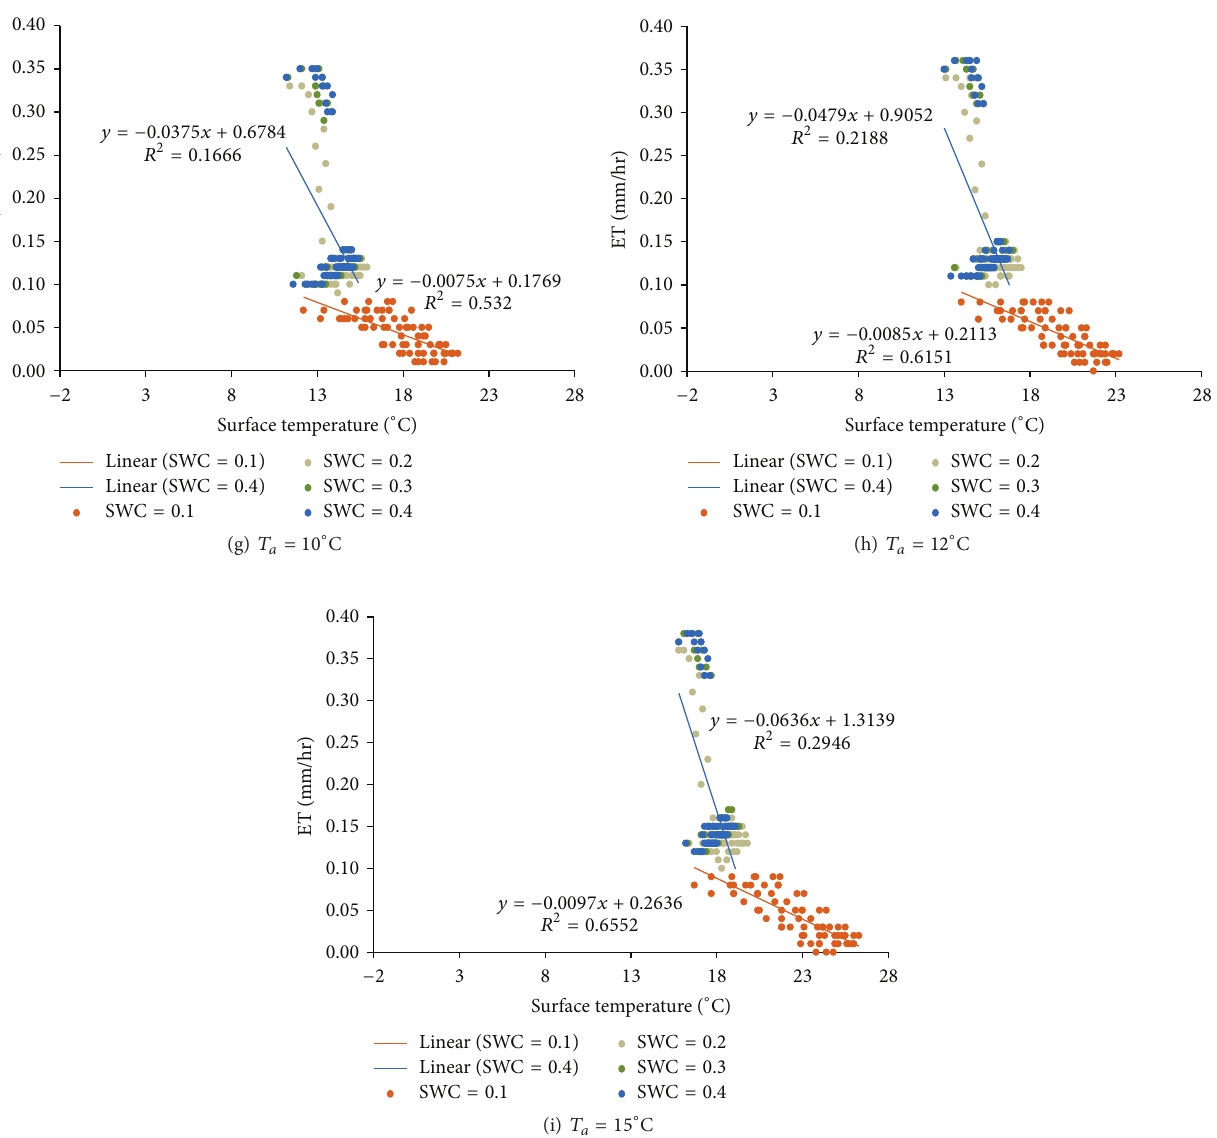
Figure 4: ET and LST under nine scenarios of air temperature and four scenarios of soil water